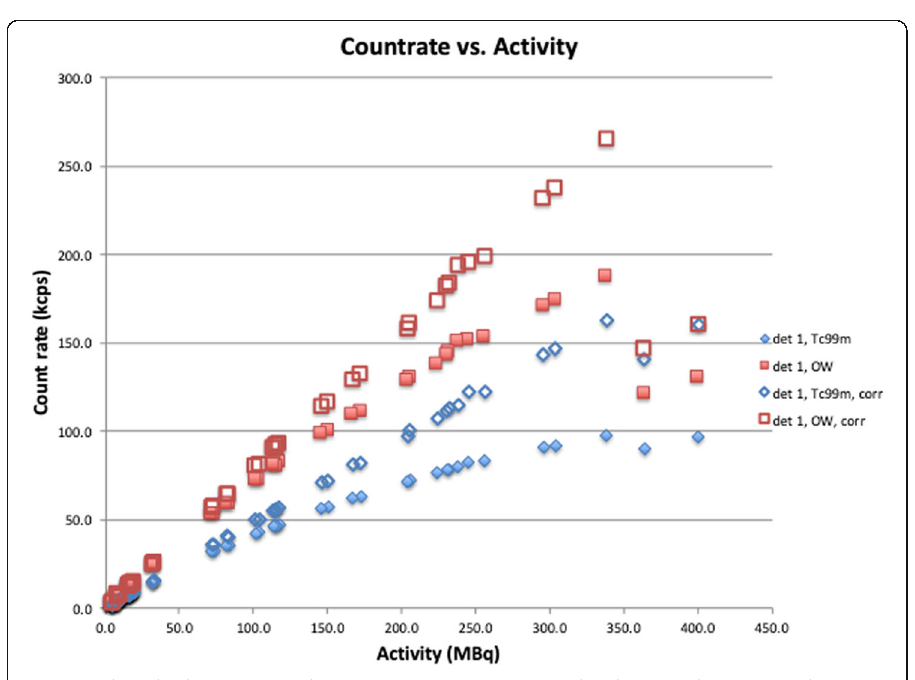
Fig. 4 Lambert dead time corrected count rates vs. activity. Measured and corrected count rates (kcps) vs. A (MBq), based on Eq. (3), using τ values from Table 2, for the intrinsic measurement for detector 1 for both energy windows: OW and 99m Tc. The slope of the corrected curve equals sensitivity,